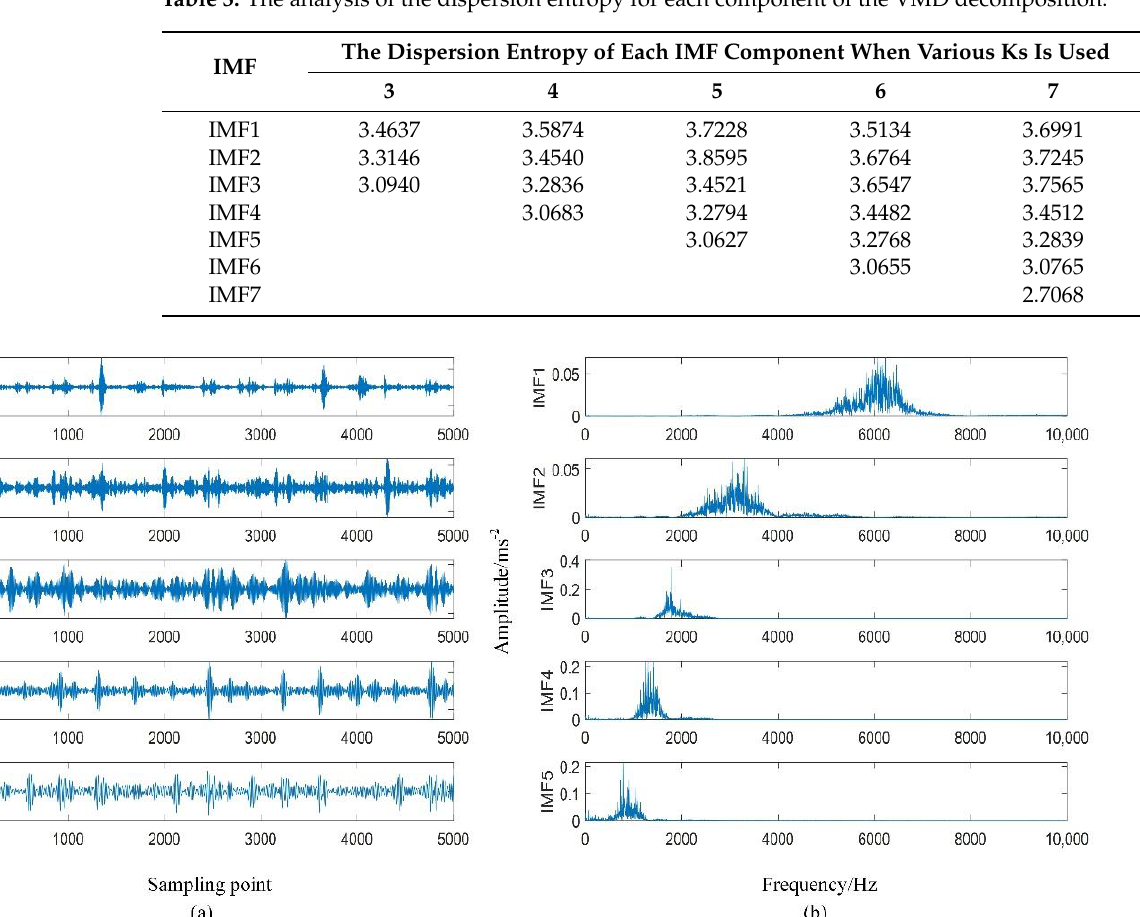
Table 3. The analysis of the dispersion entropy for each component of the VMD decomposition.